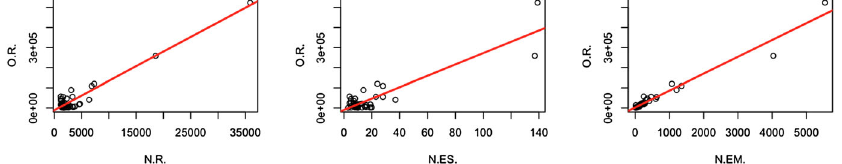
Fig.1 Relationshipbetweentotaloperatingrevenueandchainsizeasmeasuredbynumberofrooms(N.R.), establishments (N.ES.) and employees (N.EM.),